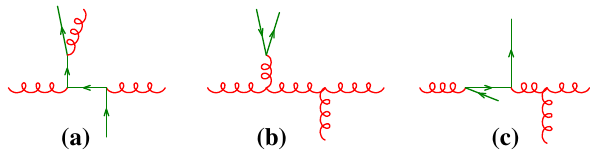
Fig. 7 Example diagrams for the three mechanism that give rise to log-enhanced contributions in heavy flavour production: a final state radiation from a quark; b gluon splitting; c flavour